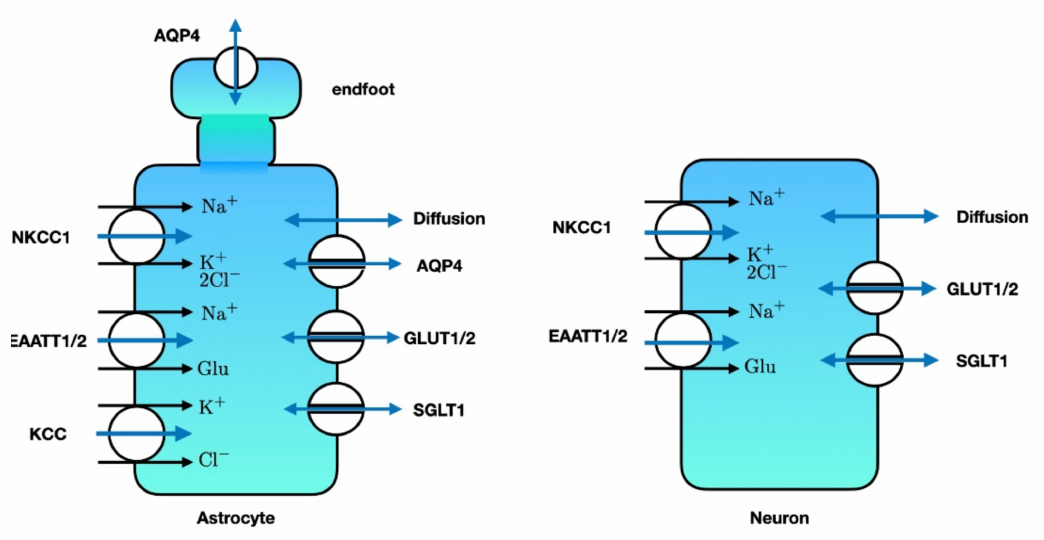
Figure 5. Major transporters and channels that allow water to enter the astrocyte ( left ) or neuron ( right ). Single-headed blue arrows denote water co-transport, while double-headed blue arrows denote passive water transport. SGLT: sodium glucose co-transporter. GLUT: glucose transporter. EAAT: excitatory amino acid transporter. NKCC1: sodium-potassium-2 chloride-co transporter. AQP4: aquaporin-4. KCC: potassium-chloride co-transporter. Note that the astrocytic endfeet mainly contain AQP4 for water transport. Illustration adapted from